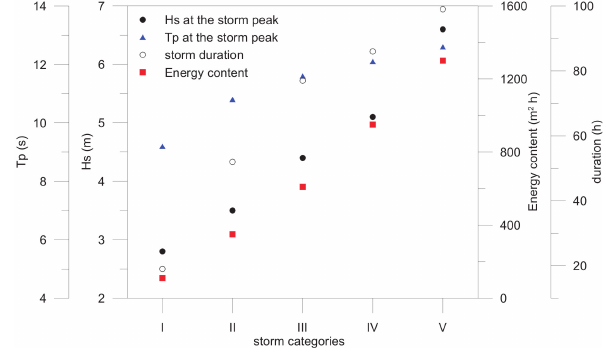
Fig. 4. Class-averaged values of wave storm properties in the Cata- lan